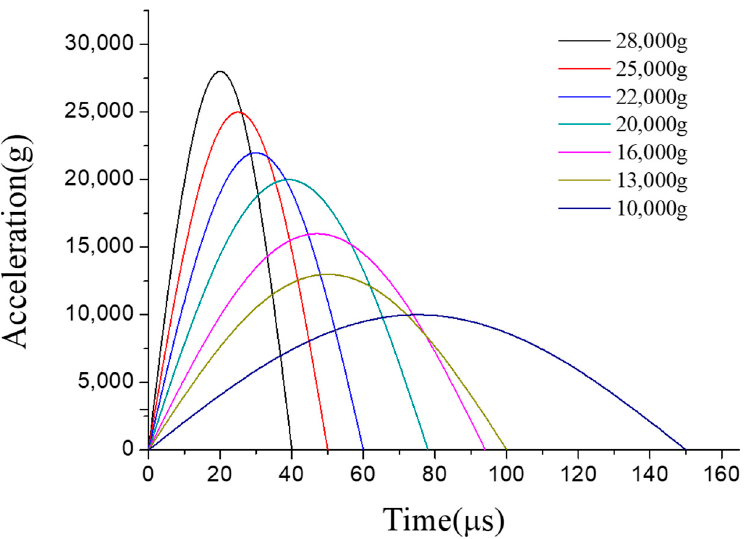
Figure 14. The fitted curves based on the measured acceleration pulses with different shock levels.